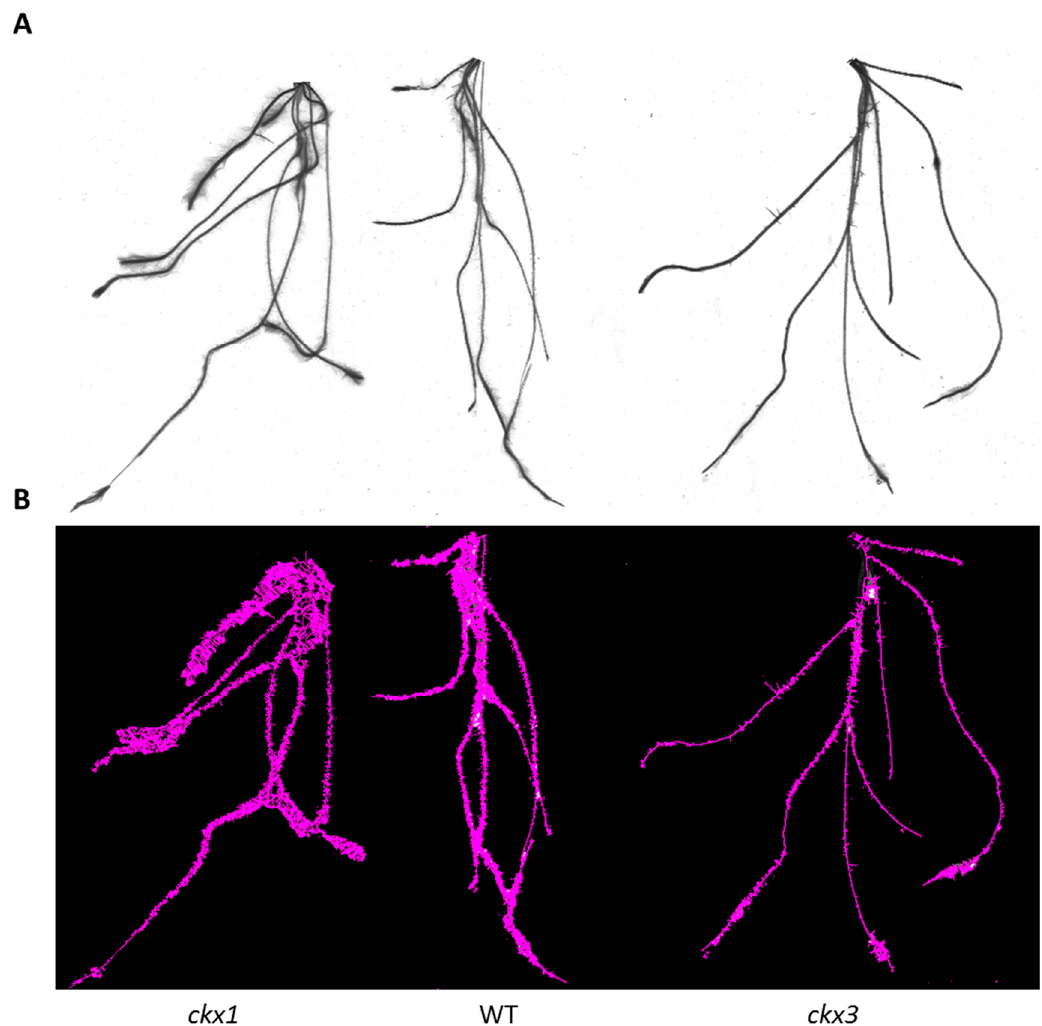
Figure 11. Examples of root phenotypes of the ckx1 mutant (left), a control plant (middle), and the ckx3 mutant (right) ( A ); differences in total surface area visualized in the images of scanned roots ( B ).